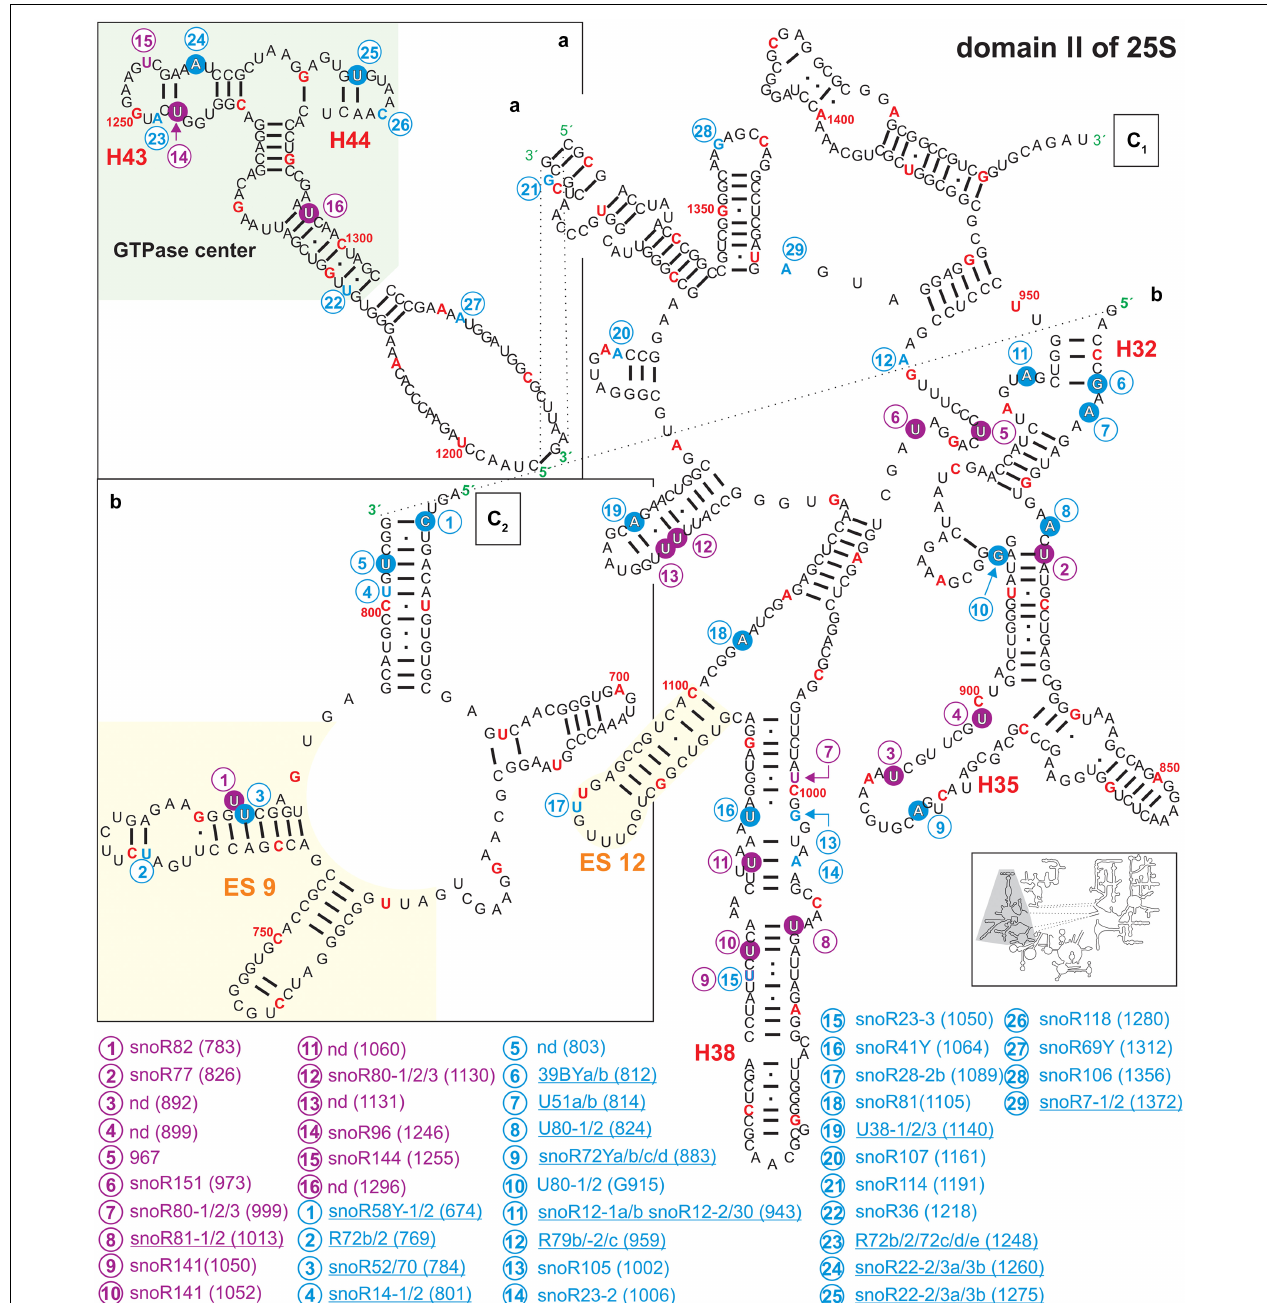
FIGURE 5 | Secondary structure diagram of domain III of 25S rRNA of A. thaliana . The image is shown according to the legend for Figure 3 . Framed large letters indicate the position of the connections in subsequent images (for C see Figure 6 ). PE annotates a pivoting element previously identified (Paci and Fox, 2015). The number in brackets correspond to the modified nucleotide position. A small illustration of the whole 60S rRNA secondary structure highlighting the according region is